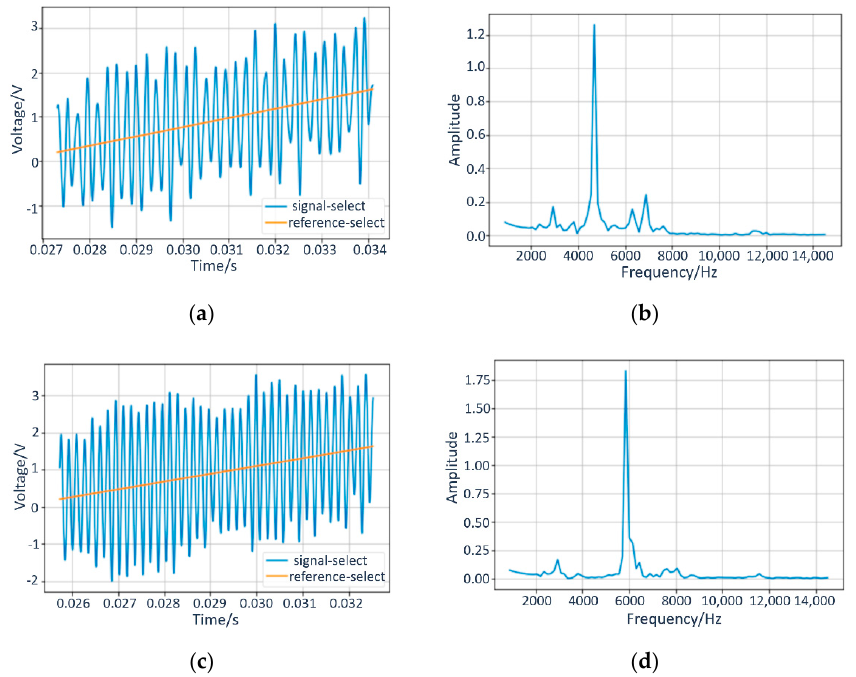
Figure 4. ( a ) Output and reference signals observed at a lens–target distance of 32 cm and ( b ) FFT of the output signal. A peak signal component of 4.7 kHz is observed. ( c ) Output and reference signals observed at a lens–target distance of 42 cm and ( d ) FFT of the output signal. A peak signal component of 5.9 kHz is